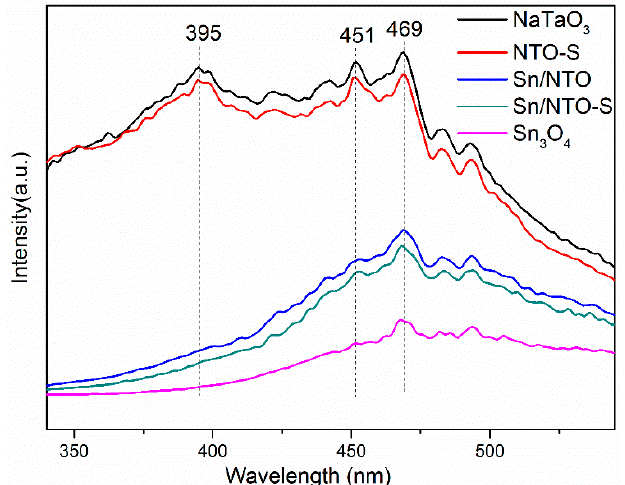
Figure 6. Room temperature photoluminescence (PL) spectra of NaTaO 3 , NTO-S, Sn/NTO, Sn/NTO-S, and Sn 3 O 4 , respectively. Sn/NTO-S, and Sn 3 O 4 ,